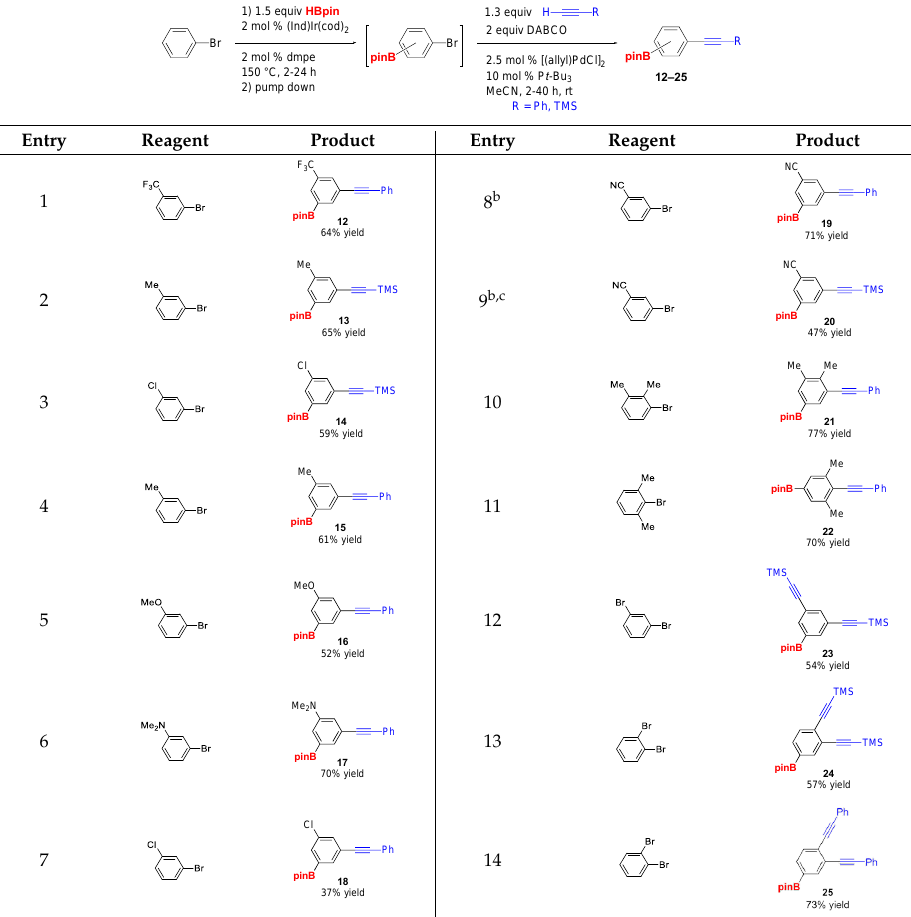
Table 1. Scope of one-pot CHB/Sonagashira cross-coupling reaction a.